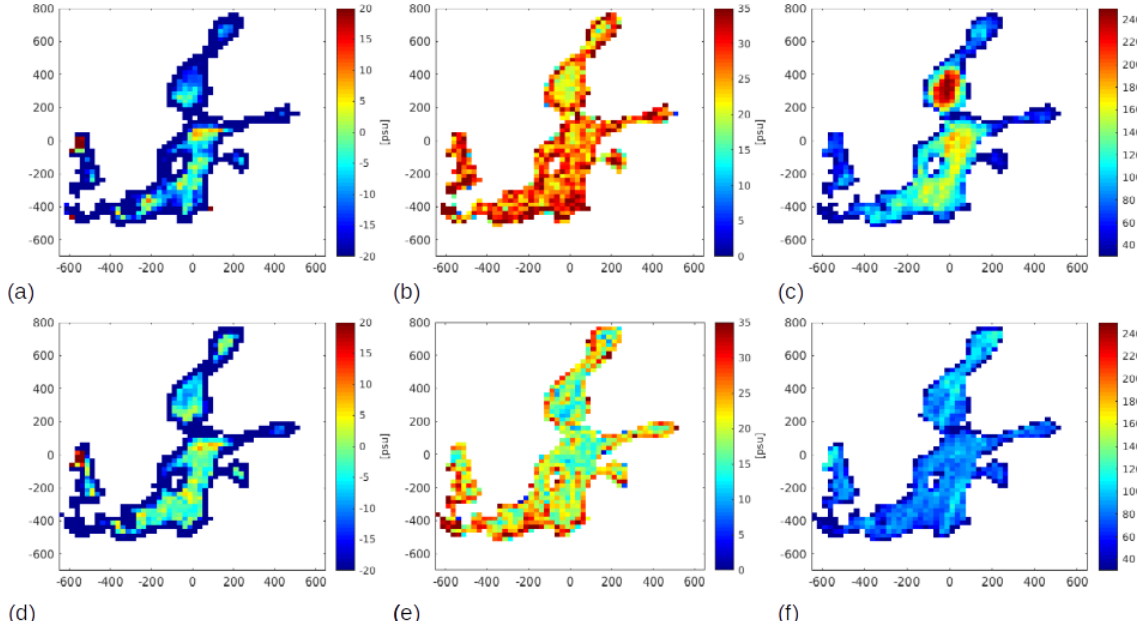
Figure 6. SMOS-based climatological distributions for descending overpasses, x = 0km and θ = 42 . 5 ◦ . (a) Mean value for the bin 2 of SST ( − 10 ◦ C < T s < 6 ◦ C), (b) standard deviation for the bin 2 of SST, (c) number of measurements for the bin 2 SST, (d) mean value for the bin 6 of SST (10 ◦ C < T s < 15 ◦ C), (e) standard deviation for the bin 6 of SST, (f) number of measurements for the bin 6 of SST. Note that axis units are in kilometres.